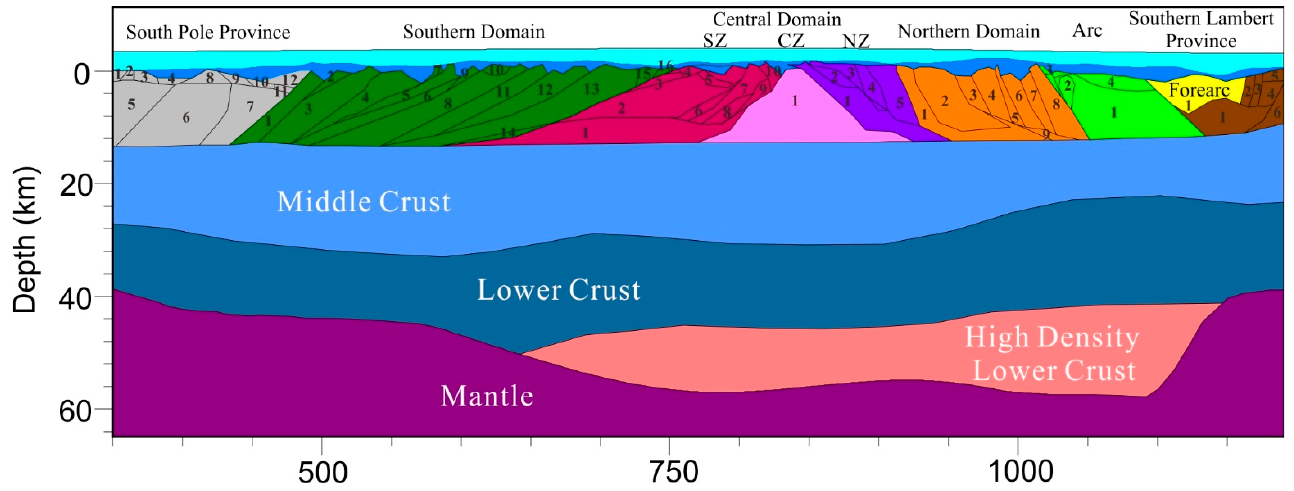
Figure A1. A sketch map of the gravity and magnetic models with individual blocks marked by numbers. The densities and susceptibilities are listed in Table A1. Table A1. Density and magnetic susceptibility settings of the gravity and magnetic models.